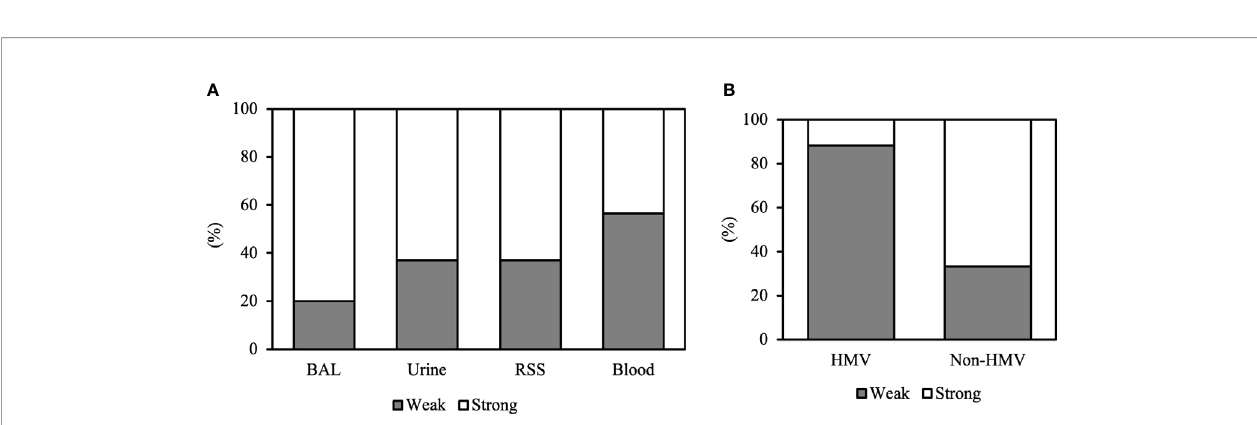
FIGURE 2 | Bio fi lm formation of CRKP clinical isolates according to (A) the site of isolation and (B) the HMV and non-HMV